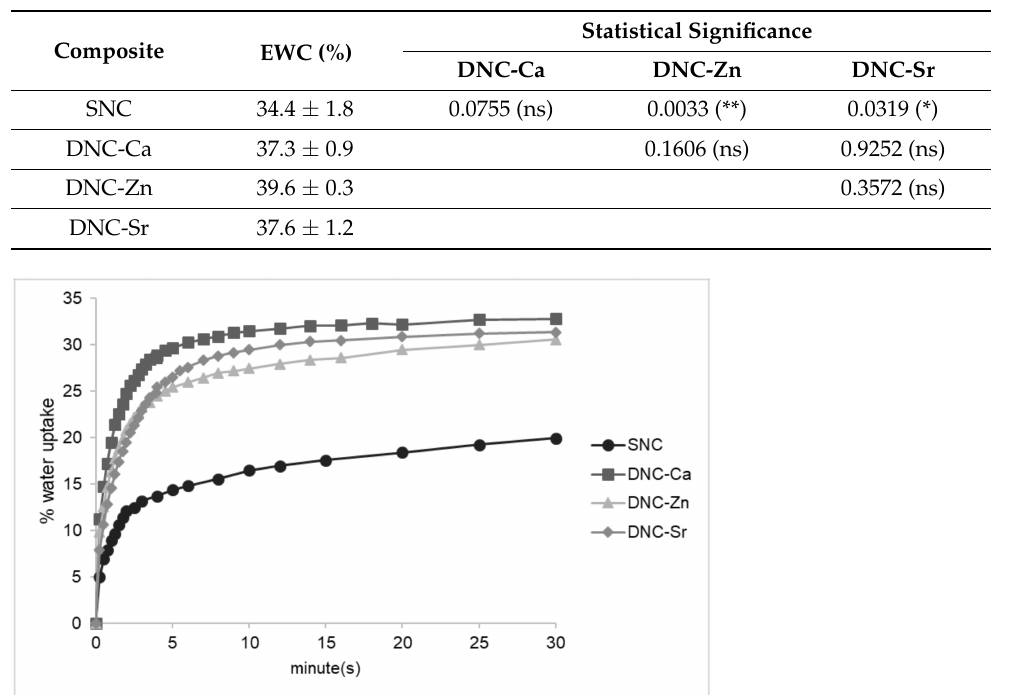
Table 3. Equilibrium water content (EWC) of dual network composites chelated with Ca 2+ (DNC-Ca), Zn 2+ (DNC-Zn) and Sr 2+ (DNC-Sr) compared to the single network composite (SNC) in deionised water at 37 ◦ C. Data are displayed as mean ± SD ( n = 3). Statistical significance was verified with